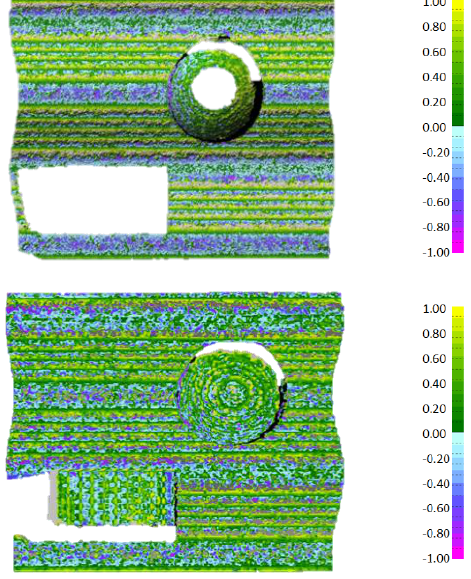
Figure 4: 3D Shape error maps (cm). Top : PhotoScan. Bottom :